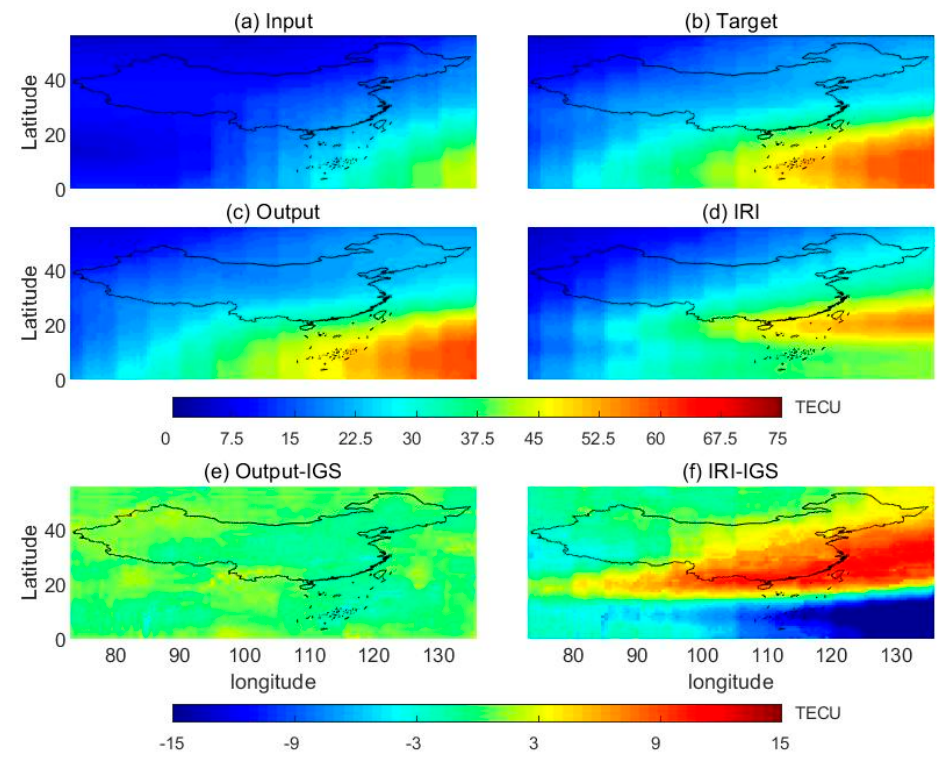
Figure 2. Comparison of the map generated by our model, the target IGS TEC map (+2 h), and the corresponding IRI TEC map (+2 h) when the input map is at 2 UT on January 6, 2014. ( a ) Input IGS TEC map, ( b ) target IGS TEC map (+2 h), ( c ) output map of our model, ( d ) IRI TEC map (+2 h), ( e ) difference map between ( c ) and ( b ), and ( f ) difference map between ( d ) and ( b ).